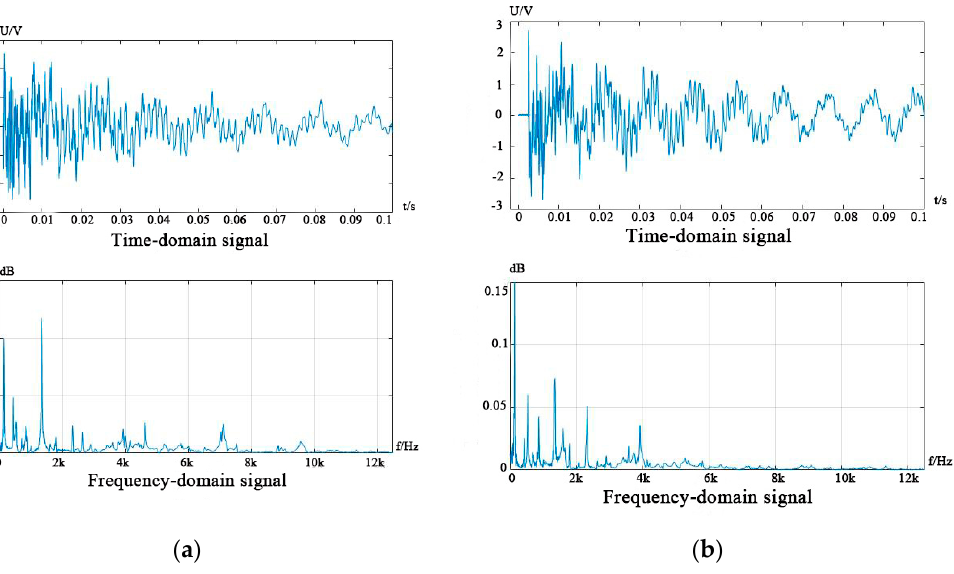
Figure 3. Time domain diagram and frequency domain diagram: ( a ) Time domain diagram and frequency domain diagram of signal generated by grains collision; ( b ) Time domain diagram and frequency domain diagram of signal generated by corncobs collision.